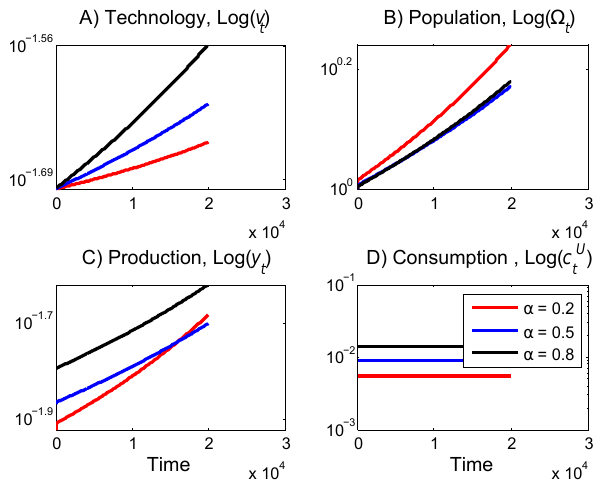
Figure 10. Case of a resilient society with highly productive skilled labor. Assumptions: η = 0.01 to represent a highly vulnerable so- ciety, low effectiveness of investment on technological change − α − β = 2 and constant availability of water re- ( γ = 1 E − 3), 1 β sources (i.e., k =